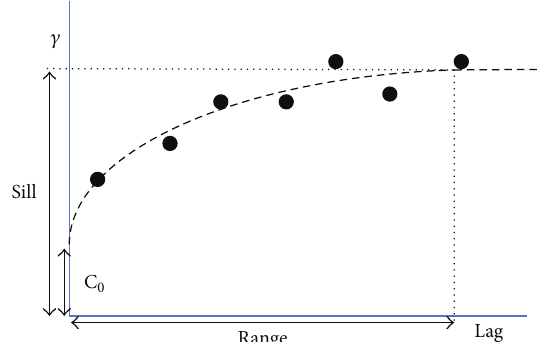
Figure11:Schematicrepresentationforrangeandsilldetermination procedure.